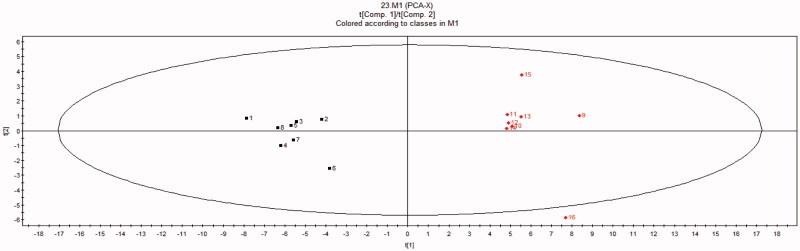
PCA score plots of liver tissue homogenate from the BD (1-8) and control (9-16) groups. Evident separated clustering of liver injury and the control groups are noted.